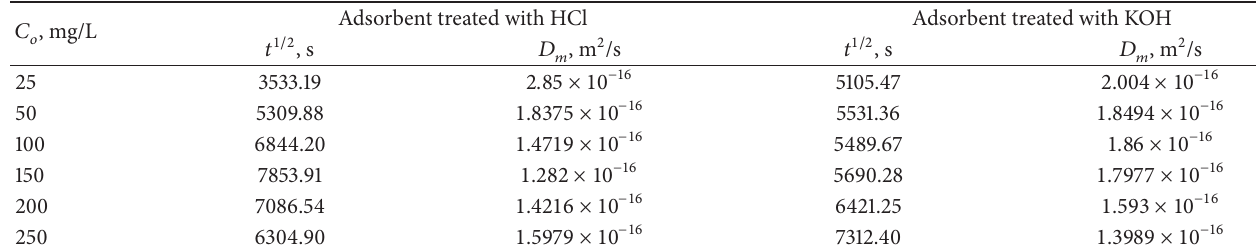
Table 8: The values of diffusion coefficient for both adsorbents at different concentrations.